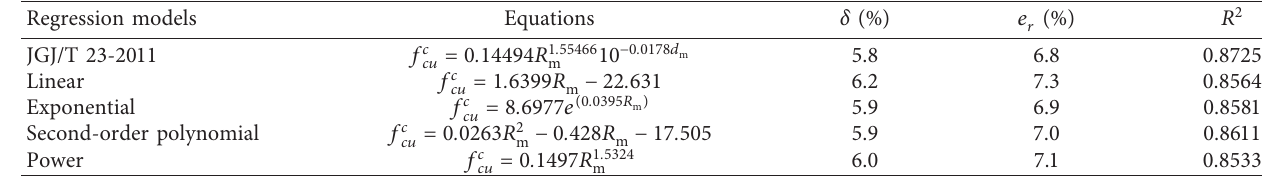
Table 8: Model equations used to estimate the relationship between HFRC compressive strength and RN.